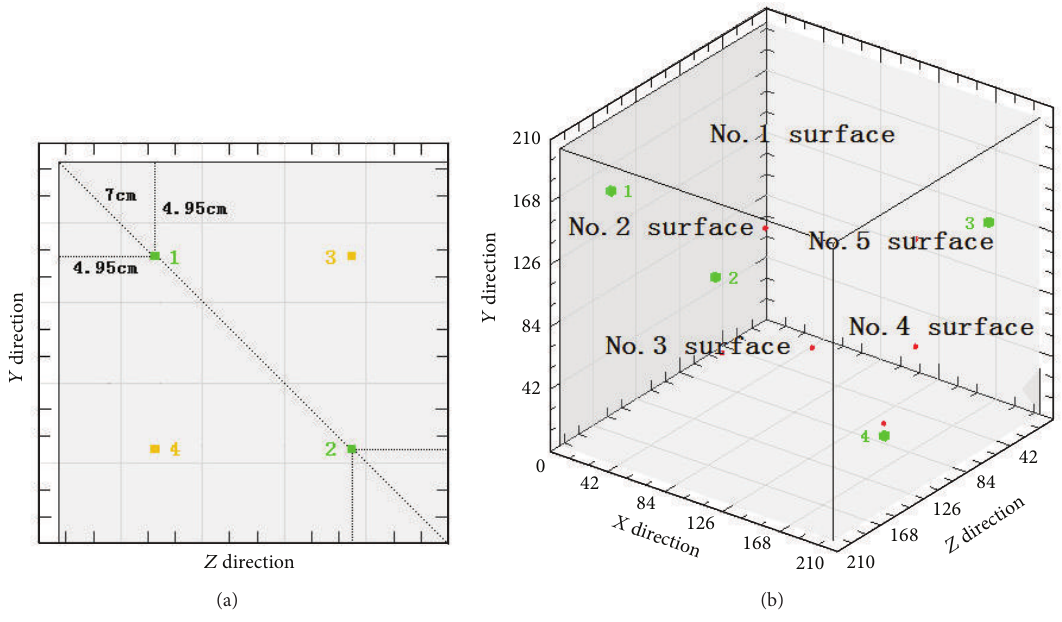
Figure 2: The position of the calibrated points.